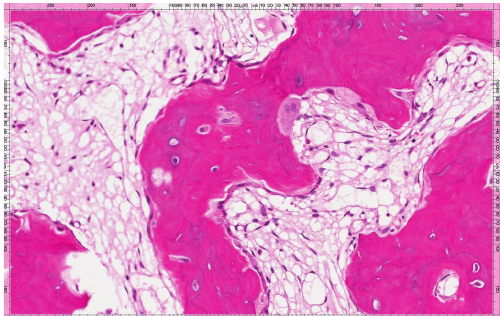
Figure 5: At higher magnification (200X, H&E stain), osteoblastic rimmingofbonetrabeculaeisnotablypresentwithfocalosteoclastic activity. There are also several resorptive surfaces in addition to reversal lines.